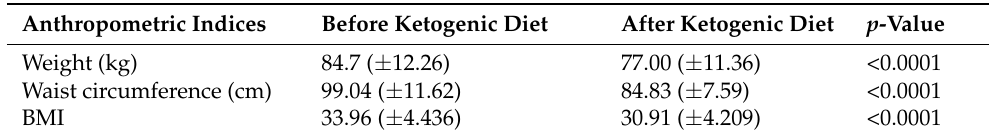
Table 2. Changes in anthropometric indices of participants ( n = 23) before and after intake of the ketogenic diet.